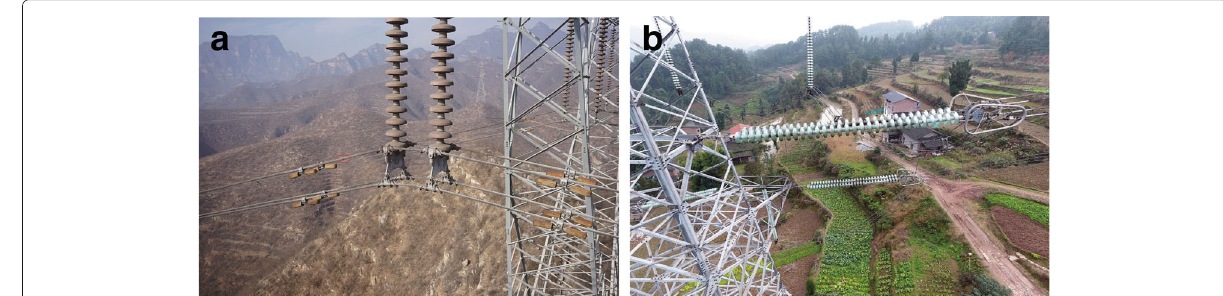
Fig. 5 The insulator image of